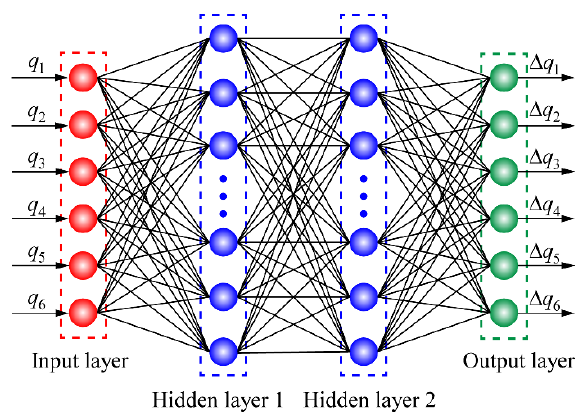
Figure 5. The structure of the BPNN.